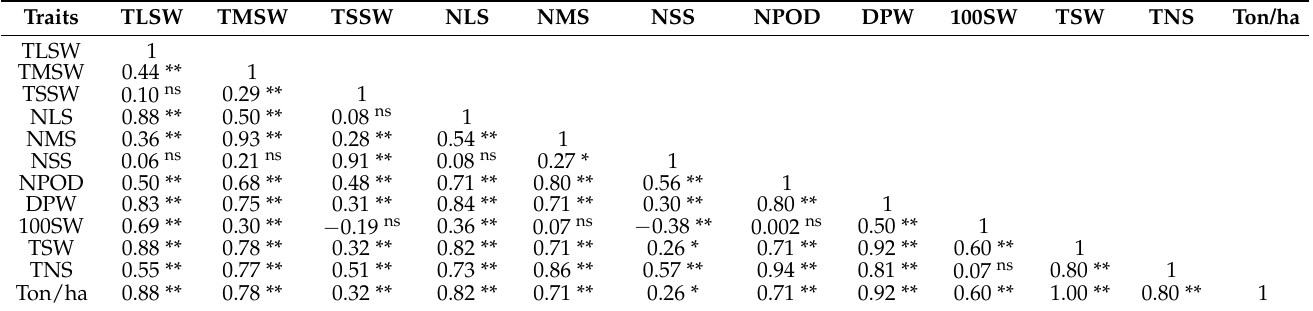
Table 7. Correlation coefficient among the 12 quantitative traits for the 28 Bambara groundnut lines.